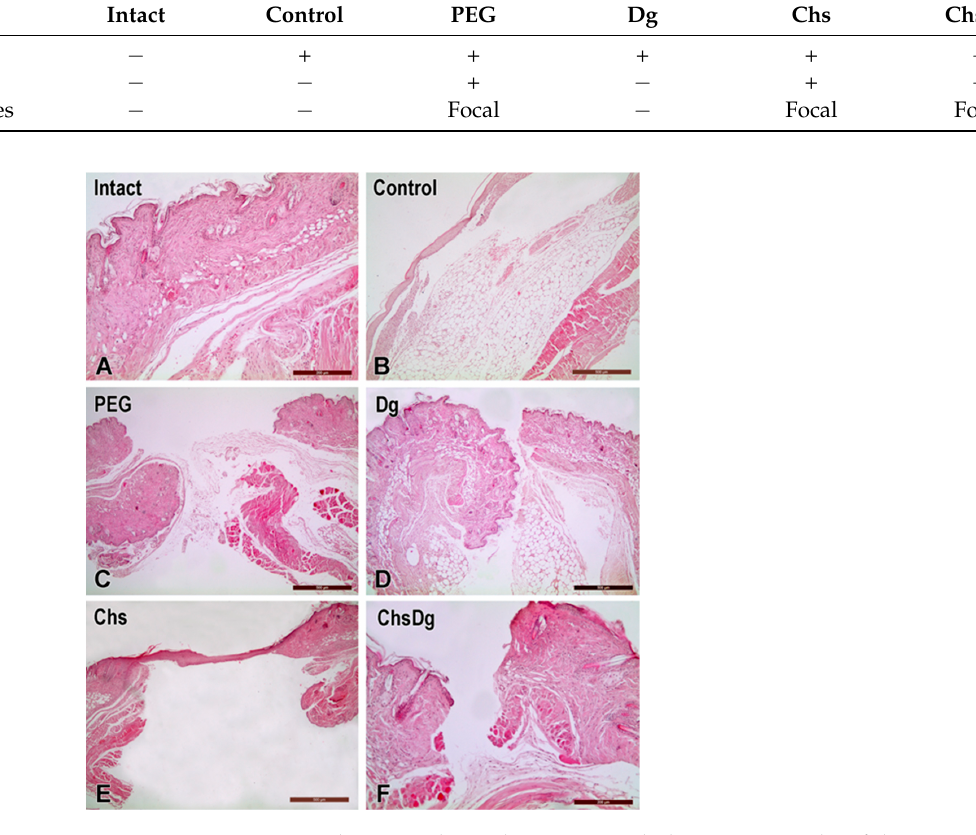
Figure 4. Representative hematoxylin and eosin stained photomicrographs of the structural organization of ( A ) mouse intact skin, ( B ) wound treated with 50% ethanol, which served as a control, ( C ) wound treated with PEG, ( D ) wound treated with Dg, ( E ) wound treated with Chs, ( F ) wound treated with ChsDg. Scale bars: 200 µm ( A , F ), 500 µm ( B – E ). Healing tests performed in mice using various combinations clearly showed that the ChsDg combination may contribute to faster wound healing without complications. 2.3. Oxidative Stress Regarding the indicators of oxidative stress, no differences were detected in LPO lev- els between intact skin and control skin. LPO was significantly lower in PEG-treated wounds and higher in Chs- and ChsDg-treated wounds compared to tissue from ethanol- treated (Control) wounds (Figure 5). Of the examined substances, only the administration of Dg retained the levels of LPO similar to control.